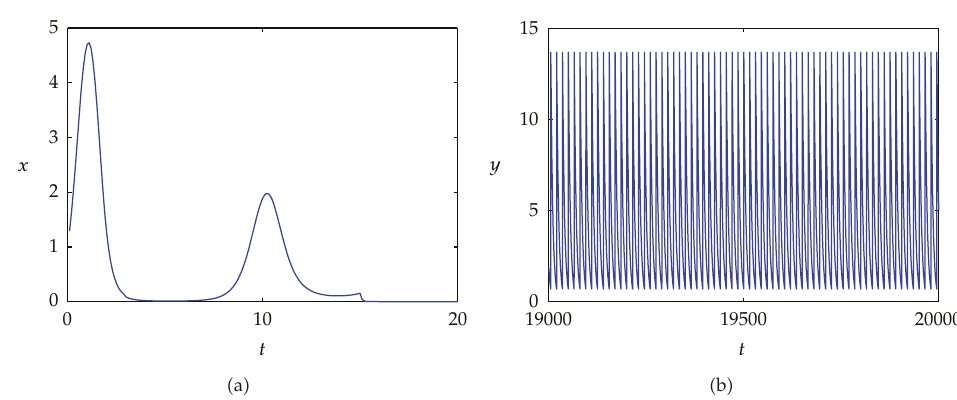
Figure 2: Dynamical behavior of (cid:3) 1.3 (cid:4) with q (cid:6) 13. (cid:3) a (cid:4) x is plotted. (cid:3) b (cid:4) y is